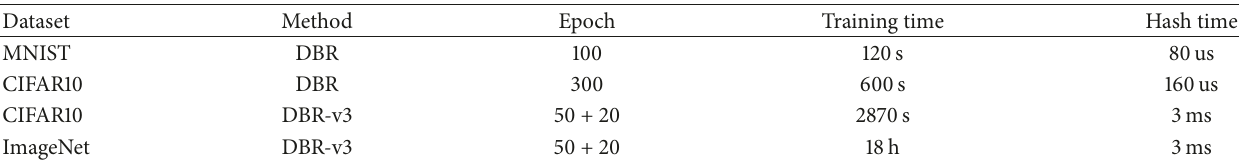
Table 6: The running time of each experiment. Training time means the time to train the hash function. Hash time means the time to map one image to hash